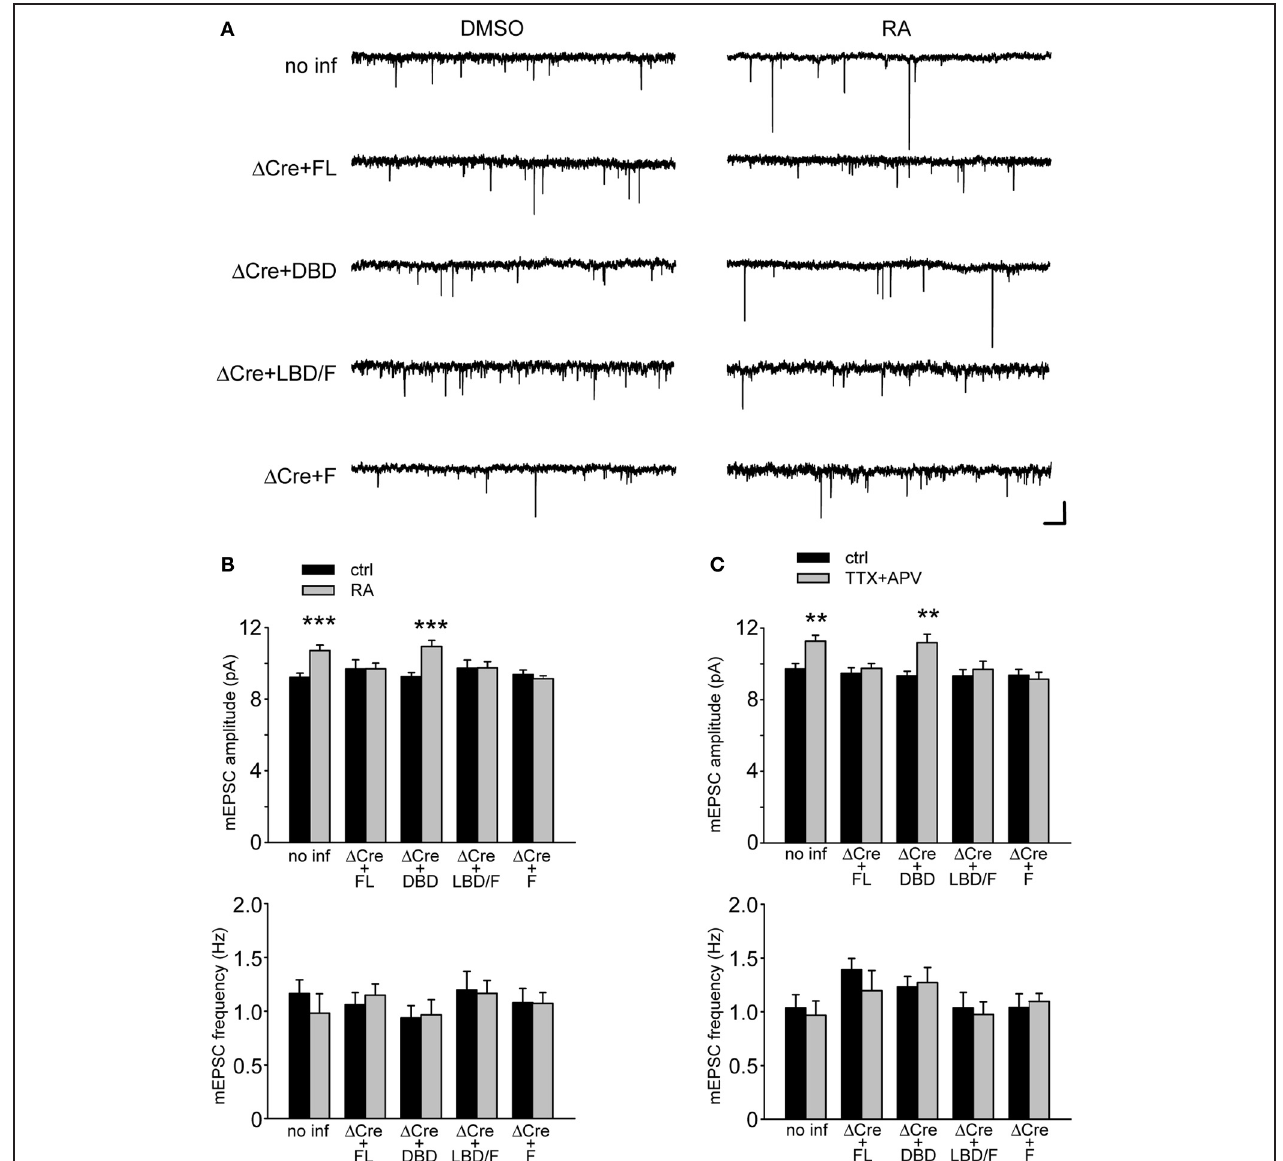
FIGURE 7 | Synaptic scaling in neurons overexpressing RAR α domains. (A) Representative traces from RAR α fl/fl hippocampal neurons infected with lentiviral vectors co-expressing (cid:2) Cre and either full-length or deletion mutants of RAR α . Neurons were treated with RA or with DMSO as control and mEPSCs recorded at − 60mV. Scale bars: 10pA, 0.5s. (B) Quantitative analysis of mEPSCs amplitude and frequency in neurons treated with